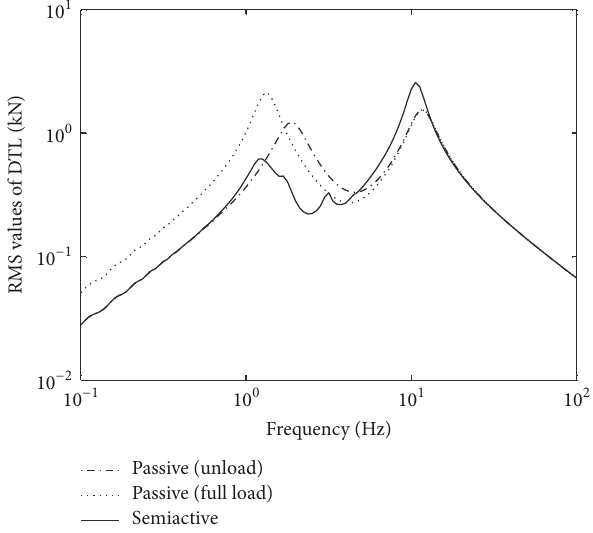
Figure 7: Frequency responses of dynamic tire load.